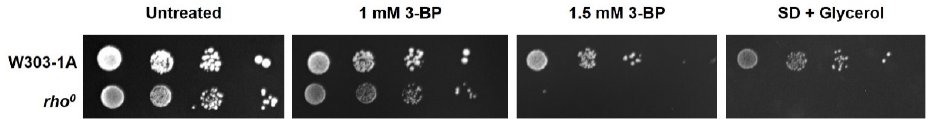
Figure 1. 3-BP causes cell death in yeast W303-1A (WT) and rho 0 strain. Logarithmically growing W303-1A (WT) and rho 0 cells were treated for 4 h with different 3-BP concentrations, incubated with PI, and viewed under a fluorescence microscope. Percent of PI-positive cells was calculated. * p ≤ 0.05.